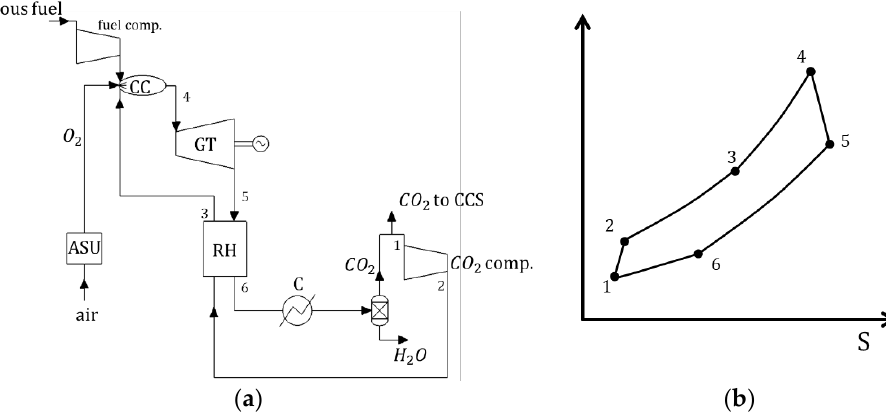
Figure 16. Oxy – fuel energy complex: ( a ) schematic diagram; ( b ) T – S diagram [26]. ASU — air sepa- Figure 16. Oxy–fuel energy complex: ( a ) schematic diagram; ( b ) T–S diagram [26]. ASU—air ration unit; CC — combustion chamber; GT — gas turbine; RH — regenerative heat exchanger; C — separation unit; CC—combustion chamber; GT—gas turbine; RH—regenerative heat exchanger; cooler.